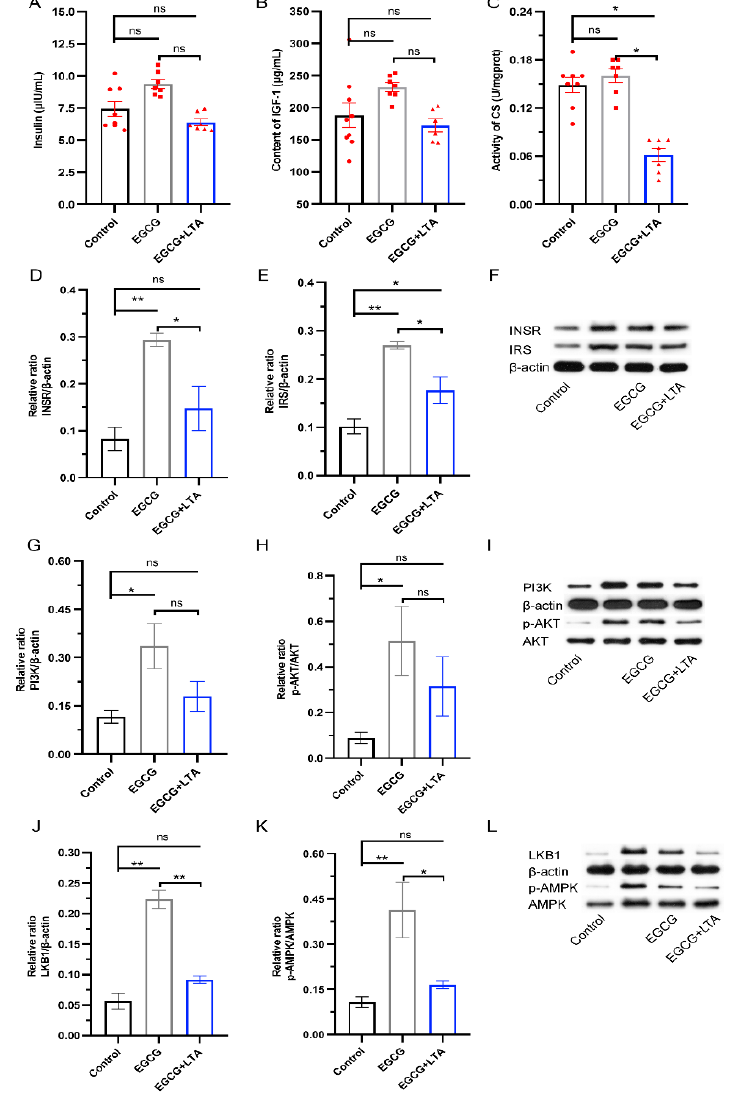
Figure 5. AMPK signals played an important role in the metabolism-regulatory effects of EGCG and EGCG+LTA. Serum insulin ( A ) and IGF-1 ( B ) contents and hepatic CS activity ( C ) in different groups. Relative protein expression of INSR ( D ) and IRS ( E ) in rat livers ( F ). Effects of different treatments on the expression of PI3K ( G ) and p-AKT ( H ) proteins ( I ). Relative expression levels of LKB1 ( J ) and p-AMPK ( K ) in rat livers ( L ). Values are expressed as the mean ± SE. * p < 0.05 and ** p < 0.01. ns: no significant difference.